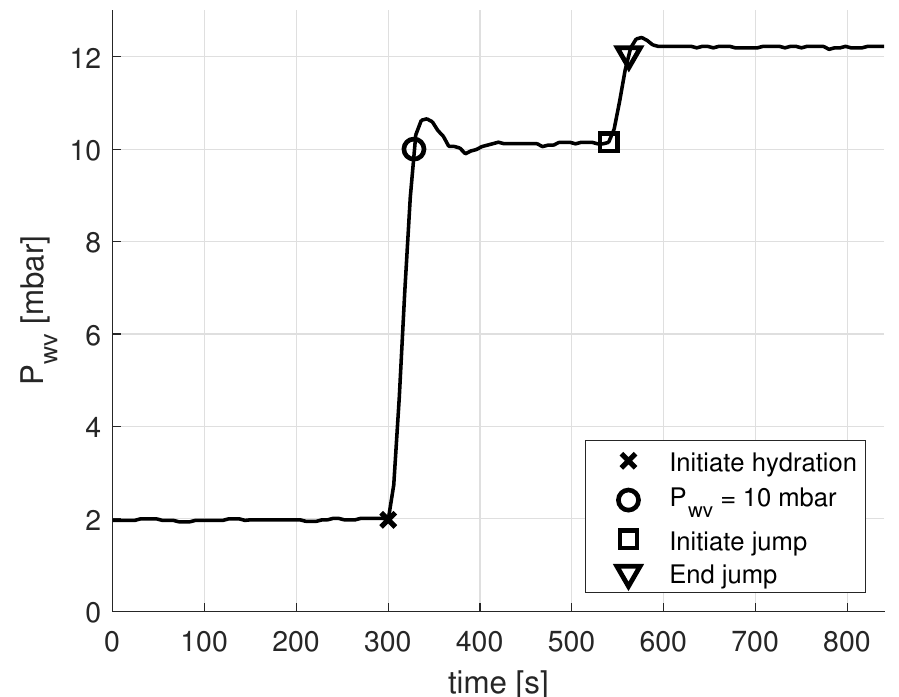
Figure 7. Representation of a ‘jump experiment’ performed using the STA.